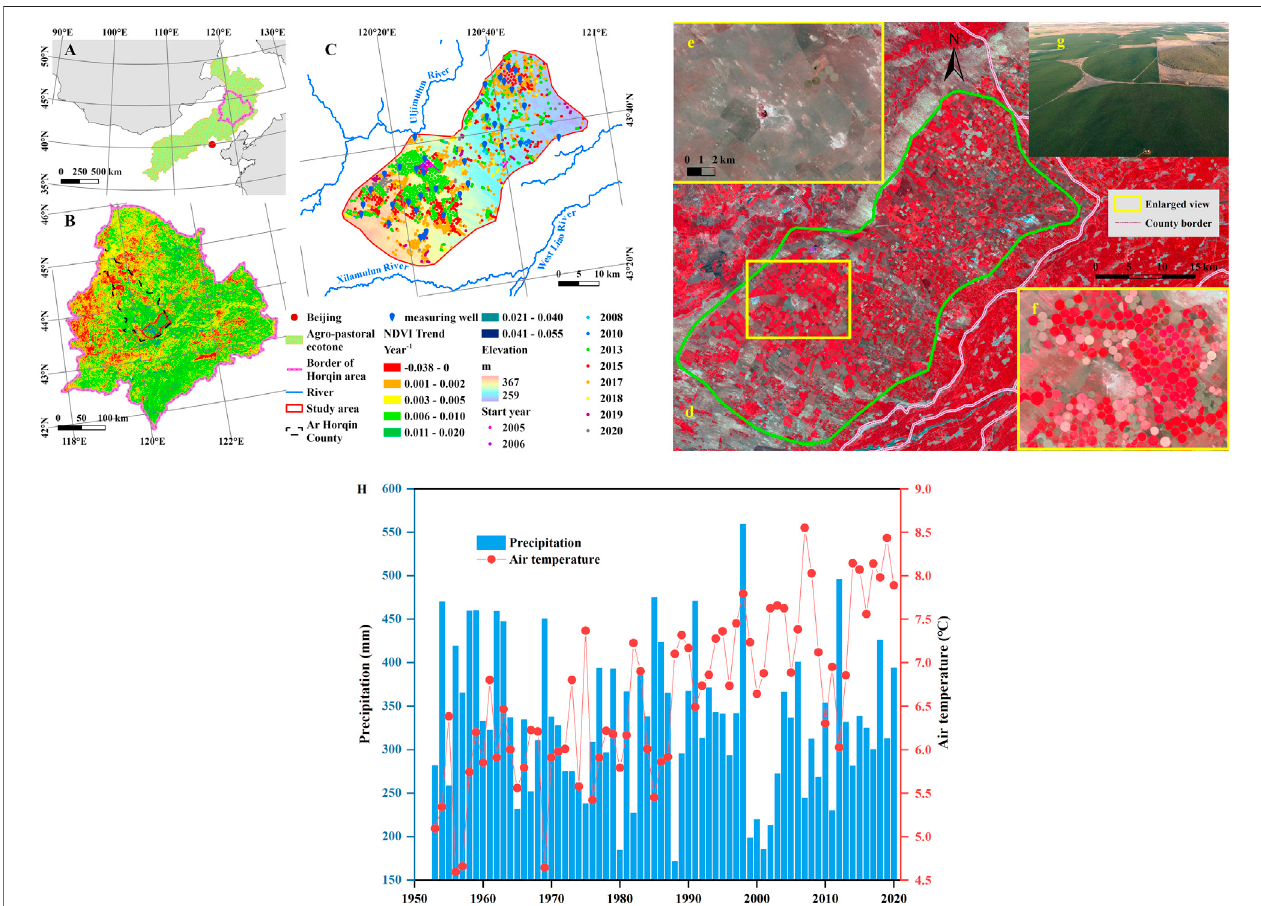
FIGURE 1 | Location and spatial characteristics of the study area. (A) The Horqin area is in the southeastern part of northern China ‘ s agro-pastoral ecotone. (B) Change rate of the normalized difference vegetation index (NDVI) in the Horqin area from 2000 to 2021. (C) The distribution of center-pivot irrigation systems that were implemented from 2005 to 2020. (D) Landsat image of the study area in 2020, with magni fi cation of local Landsat images in 2005 (E) and 2015 (F) , and an aerial photograph of a center-pivot irrigation system (G) . (H) The interannual dynamics of precipitation and air temperature in the past half century from a